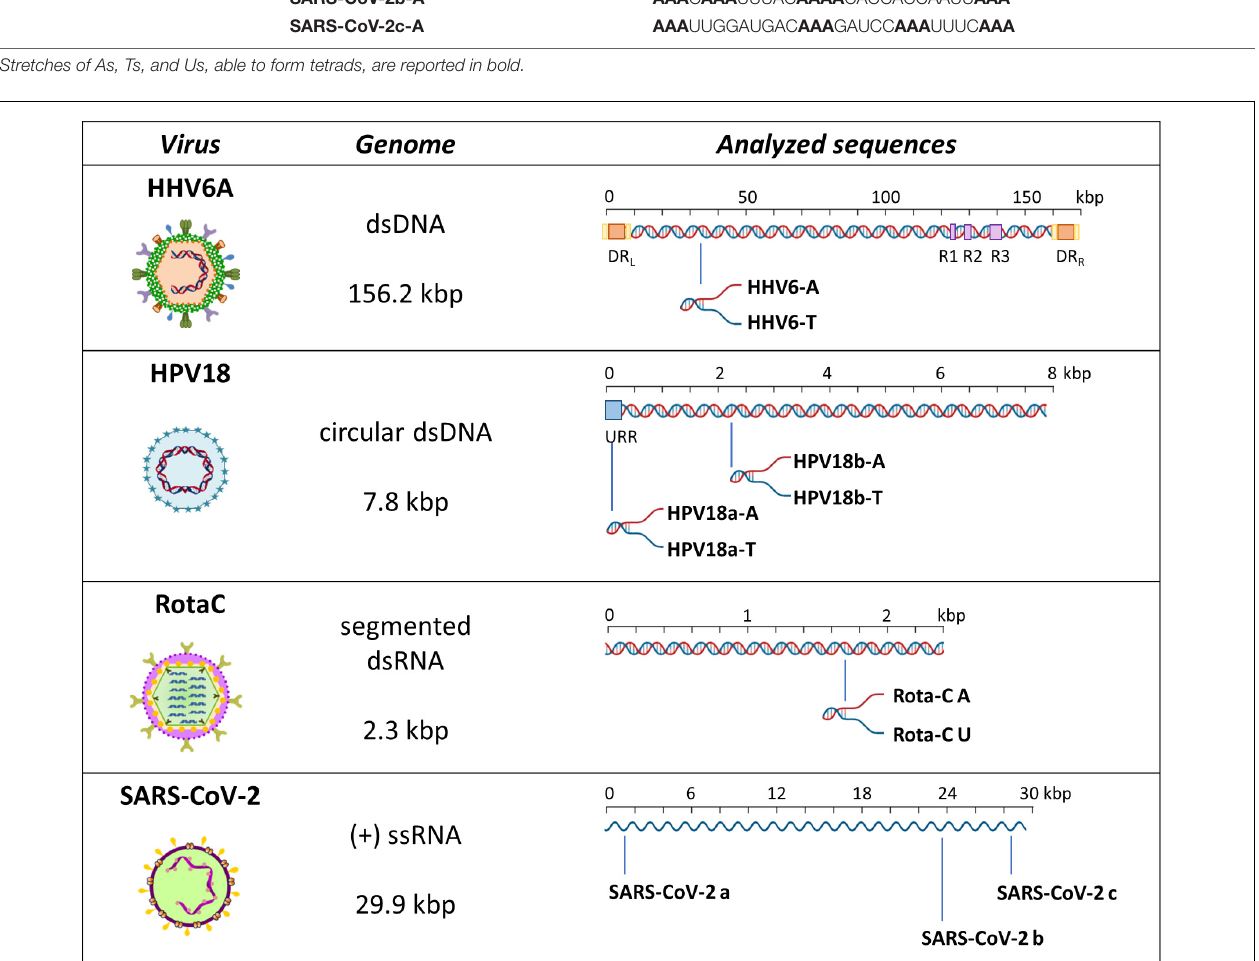
Frontiers in Microbiology |